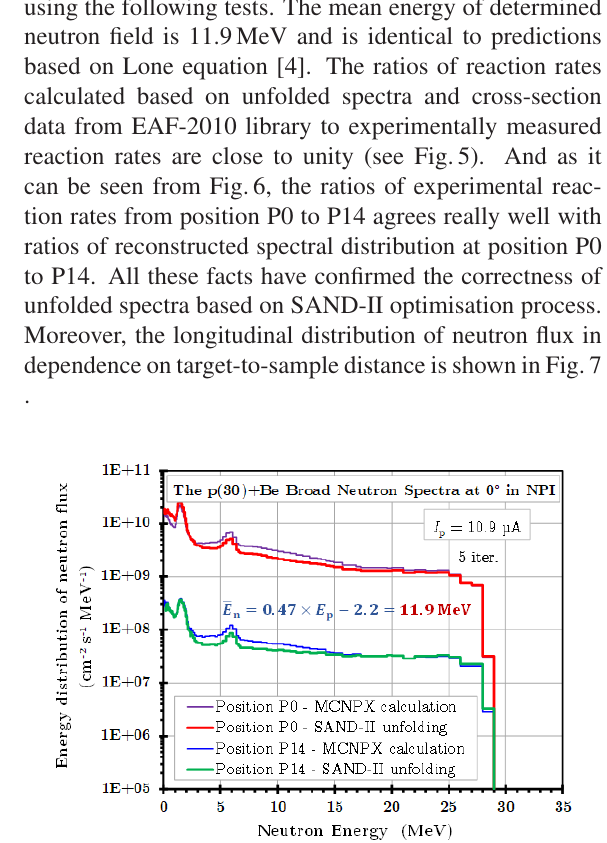
Figure 3. Novel p(30) + Be neutron spectra of NG-2 generator at two irradiation positions measured using multi-foil activation technique at NPI. Figure 2. Beryllium target station driven by isochronous cy- clotron U-120M at NPI Rez.